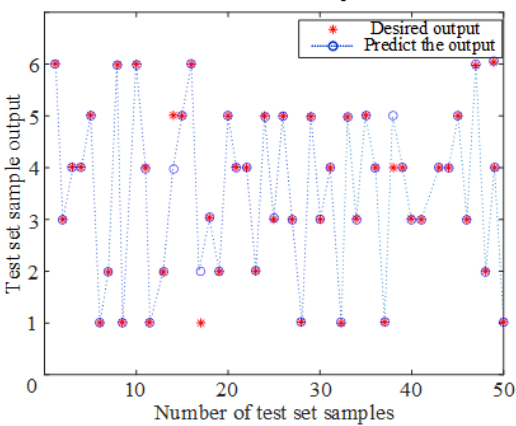
Figure 16. PSO-RVFLNS test output.